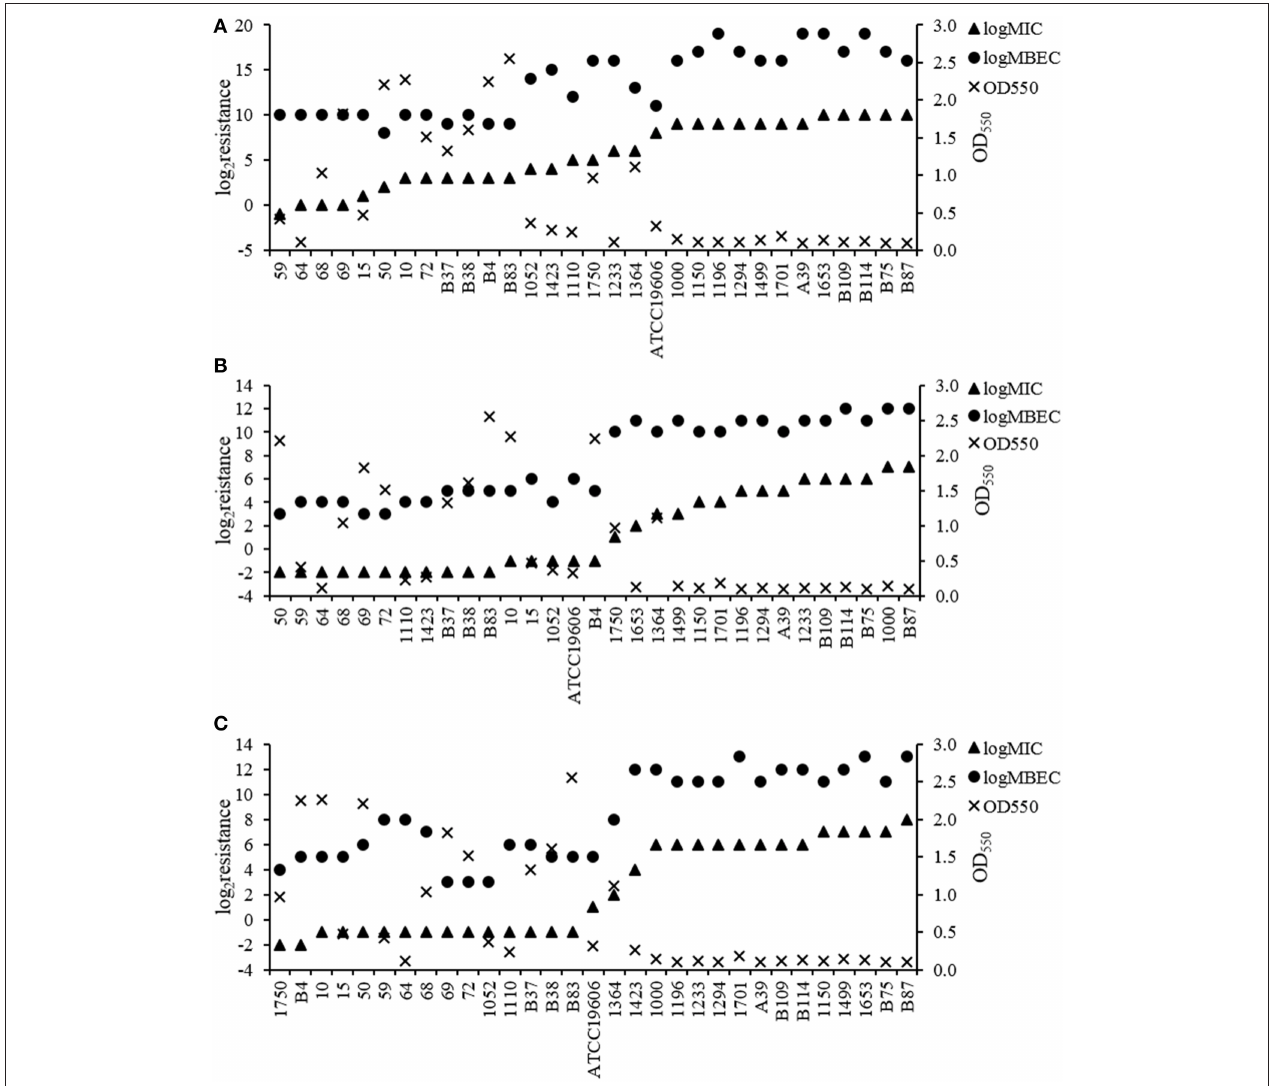
FIGURE 4 | Resistance in A. baumannii to cefotaxime, imipenem, and ciprofloxacin during planktonic and biofilm growth. (A) Cefotaxime. (B) Imipenem. (C) Ciprofloxacin. For these three antibiotics, biofilm-specific resistance (MBEC) was consistently higher in isolates with higher antibiotic resistance of planktonic bacteria (MIC). The enhancement in resistance after biofilm formation occurred independent of biofilm